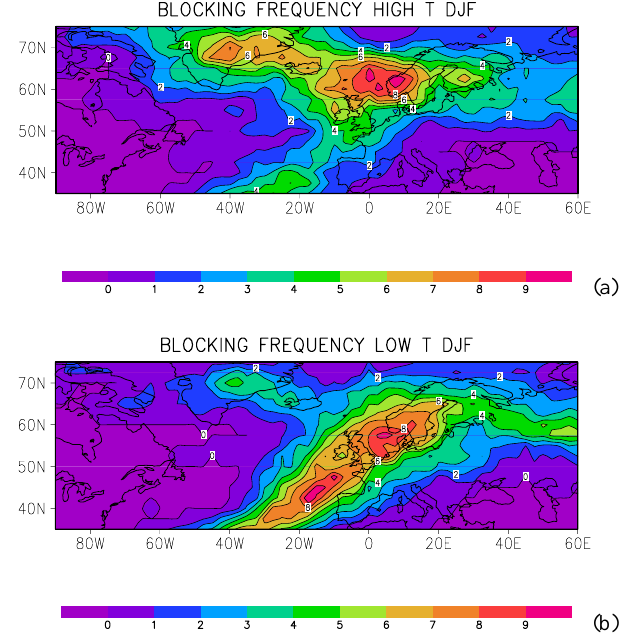
Fig. 4. (a) Blocking frequency composite for (a) high and (b) low southwestern Greenland temperatures during winter. Units are per- centage of blocked days to total number of days per winter. Period is 1908–2005.